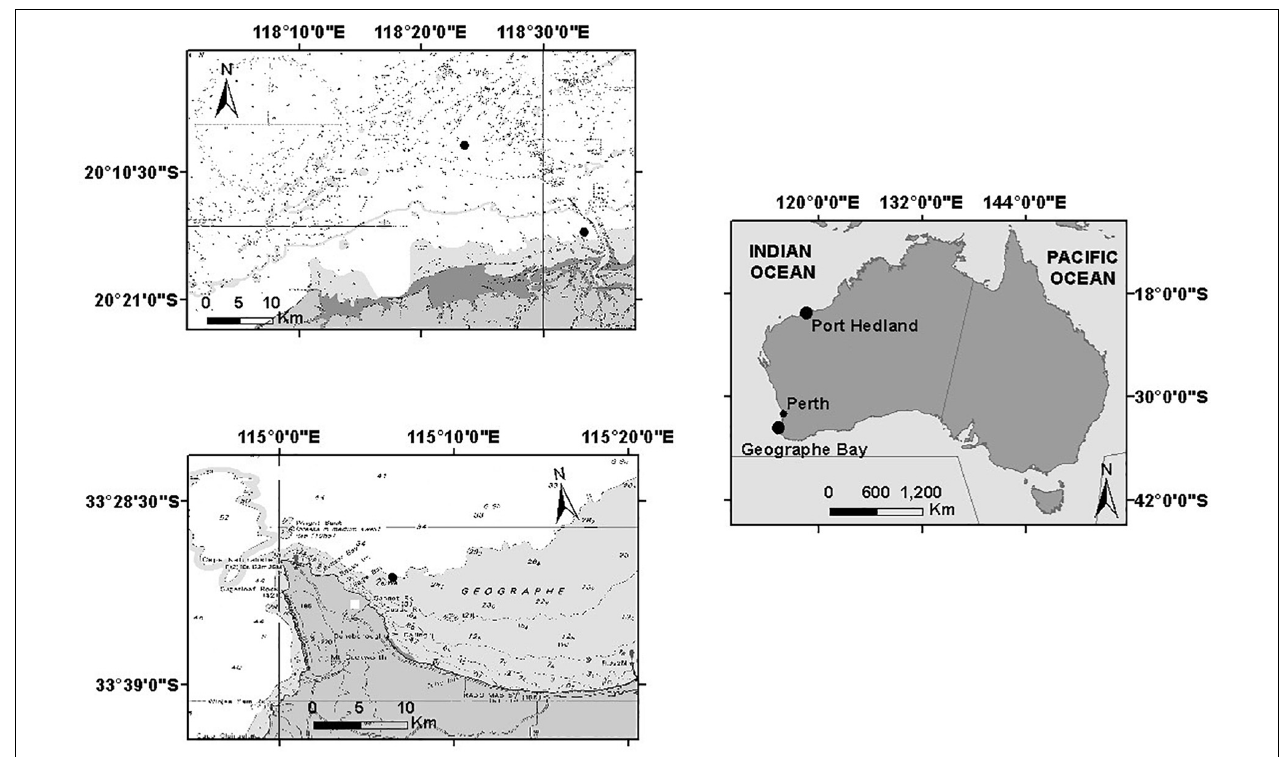
FIGURE 1 | Geographic locations of noise recorder deployments in Port Hedland and Geographe Bay, Western